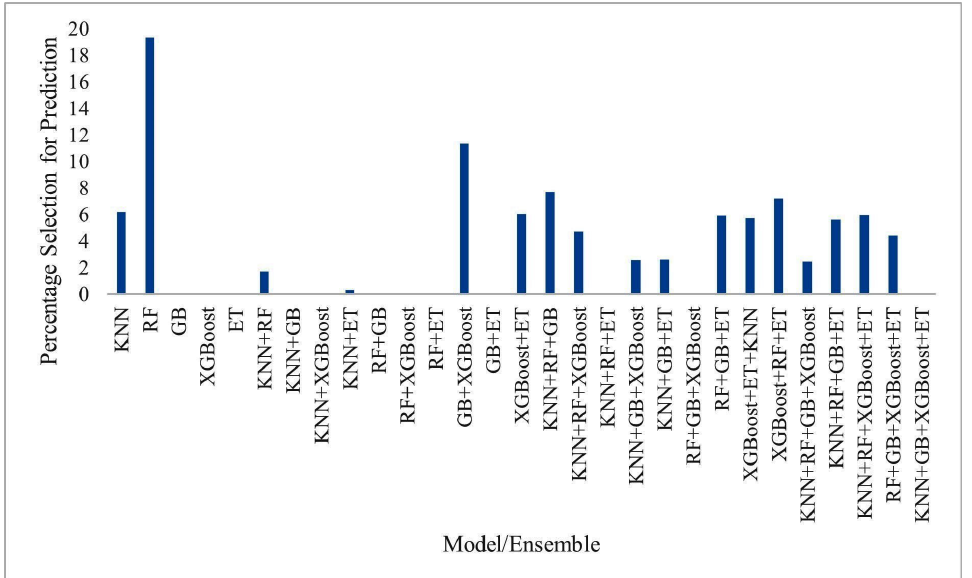
Figure 8. Percentage of model selection in DRS for dataset 1.